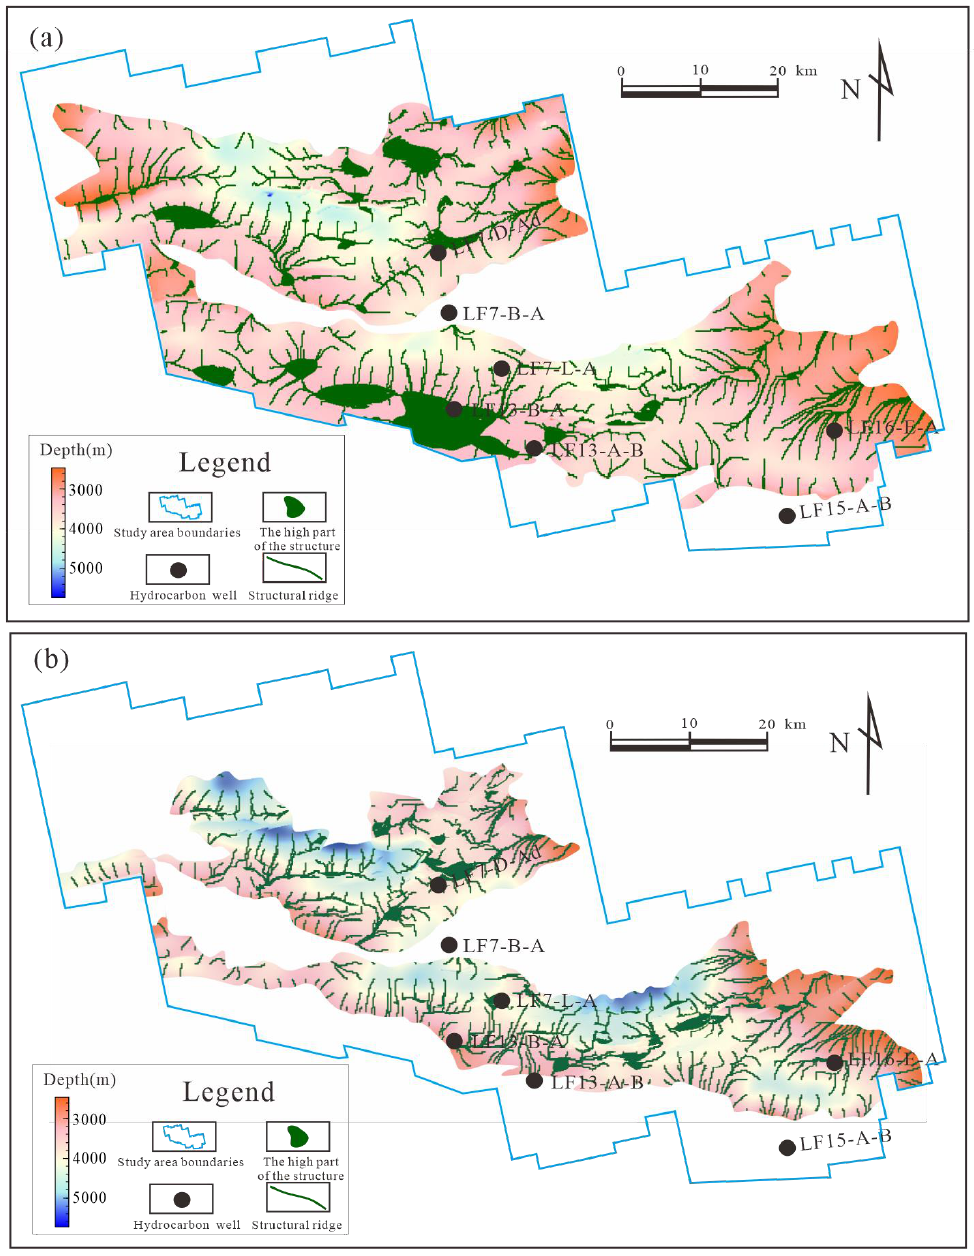
Figure 13. Plane distribution characteristics of structural ridges in Lufeng sag: ( a ) the upper WC; ( b ) the lower WC.